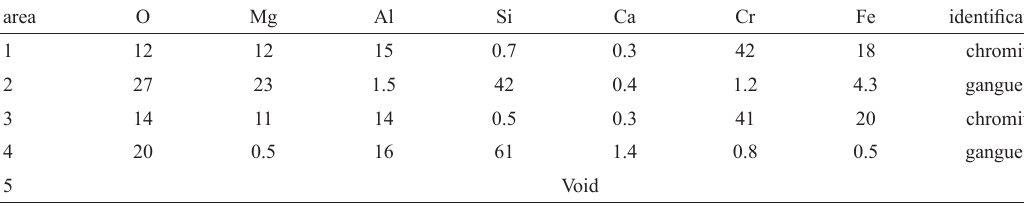
Table 2: Microanalysis (wt%) by EDS of the phases shown in figure 1